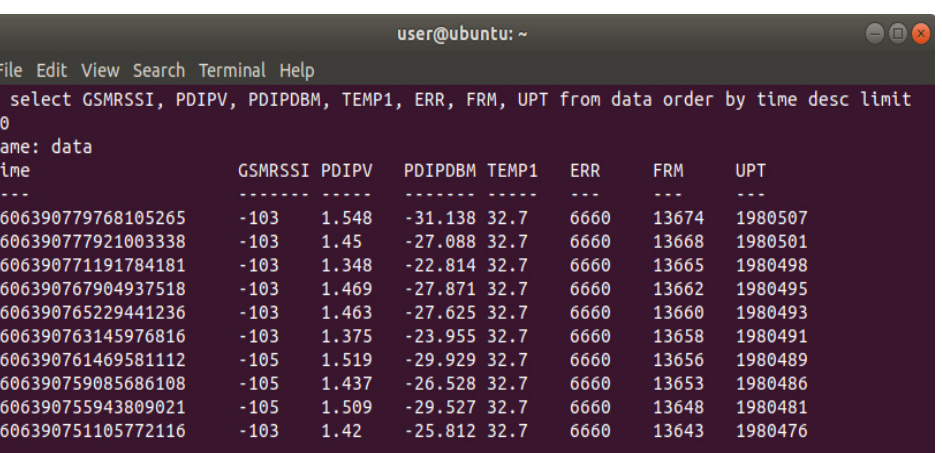
Figure 11. A sample of values stored in database, both ADC reading and converted values.